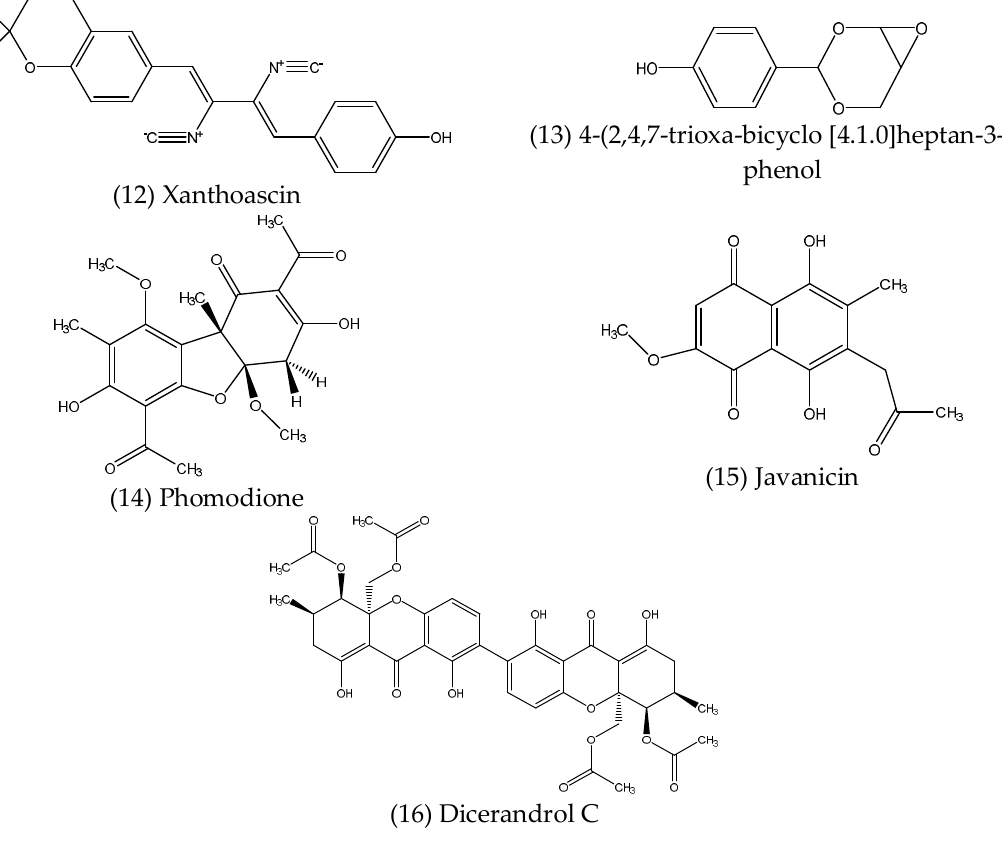
Figure 4. Structures of antimicrobial phenolic compounds produced by endophytes.